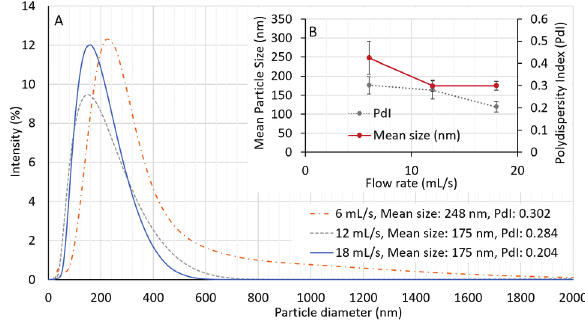
Figure 3: Overall PSD showing the primary peak and an agglomeration peak.